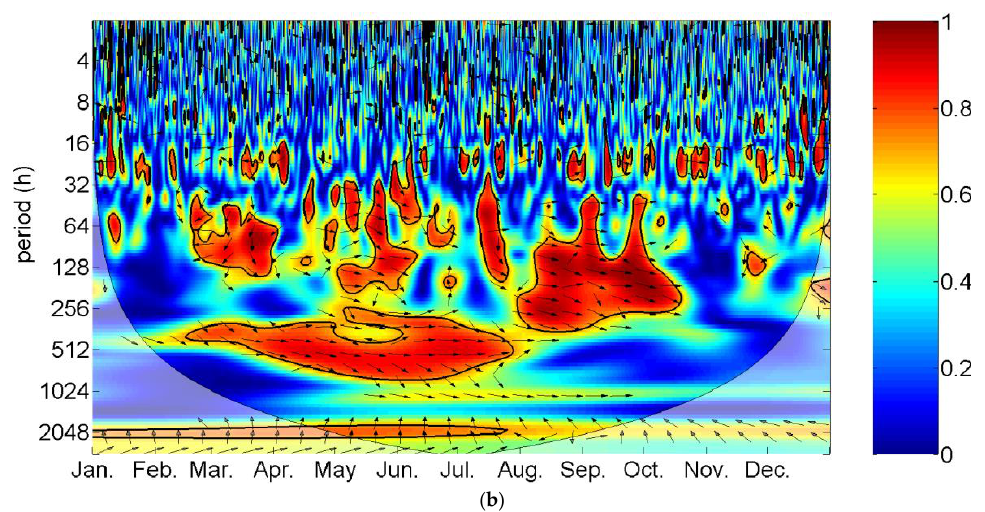
Figure 10. Scalograms of the wavelet coherence (WTC) analysis: ( a ) wavelet coherence between WQI upstream and WQI downstream; ( b ) wavelet coherence between water level downstream and WQI downstream.